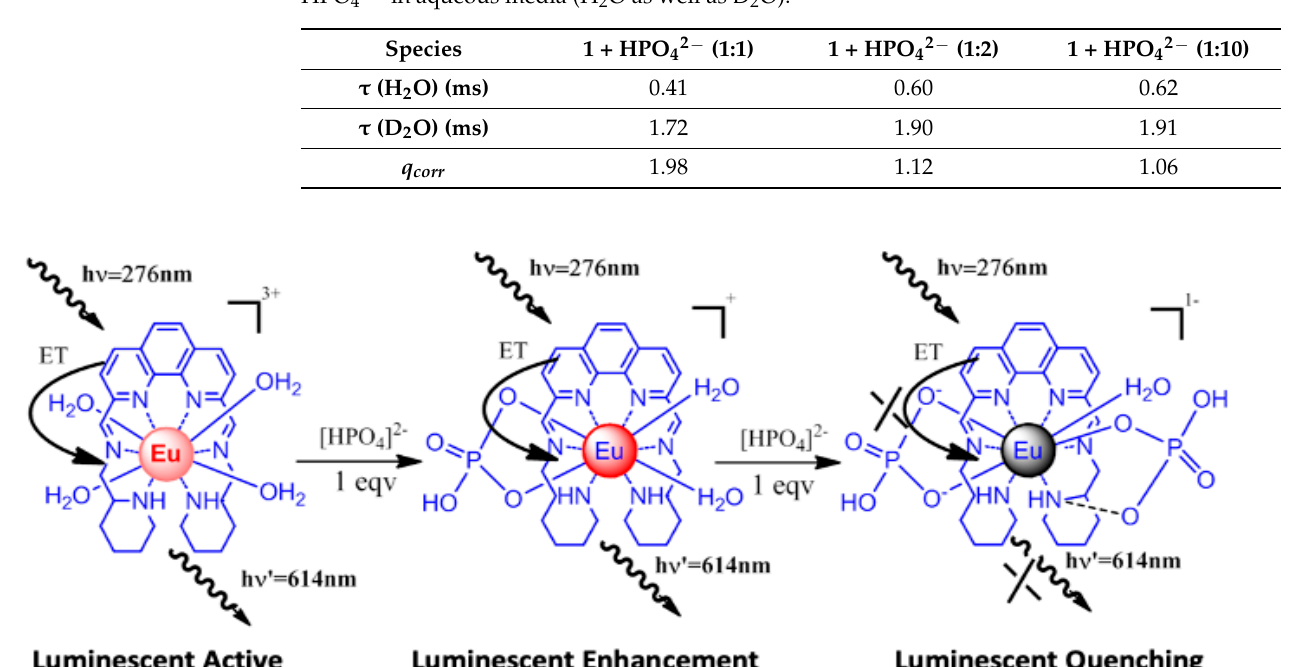
Figure 5. Proposed mechanistic pathway for successive HPO 42 − binding with 1 in aqueous medium.